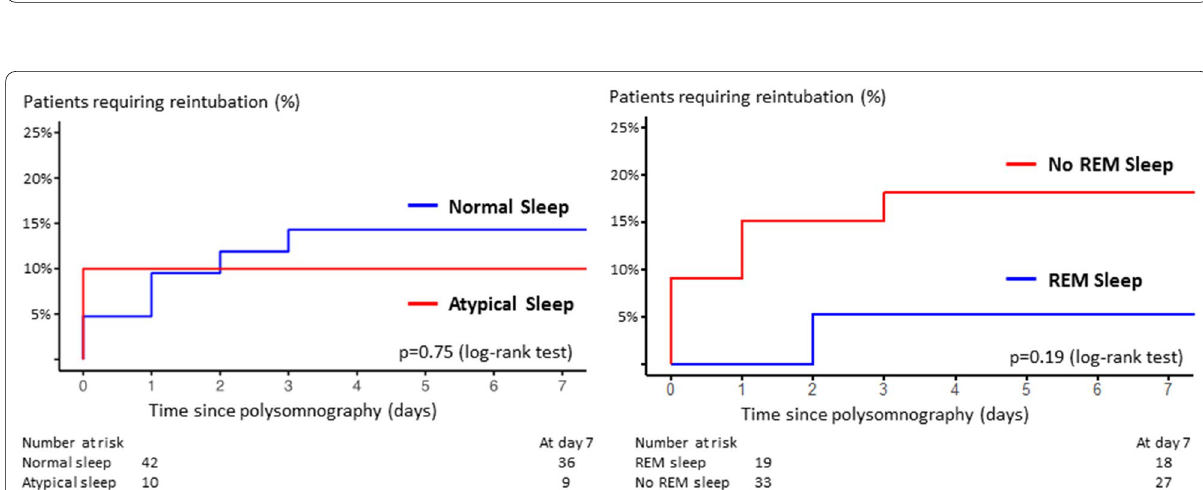
Fig. 4 Kaplan–Meier curves showing time from polysomnography to reintubation according to the presence of atypical sleep or normal sleep (at left) and the presence or not of rapid eye movement (REM) sleep. The rates of reintubation within the first 7 days after polysomnography was 14% (6/42) in patients with normal sleep vs. 10% (1/10) in those with atypical sleep (p 0.75 using log‑rank test), and was 5% (1/19) in patients with REM = sleep vs. 18% (6/33) in those with no REM sleep ( p 0.19 using log‑rank =